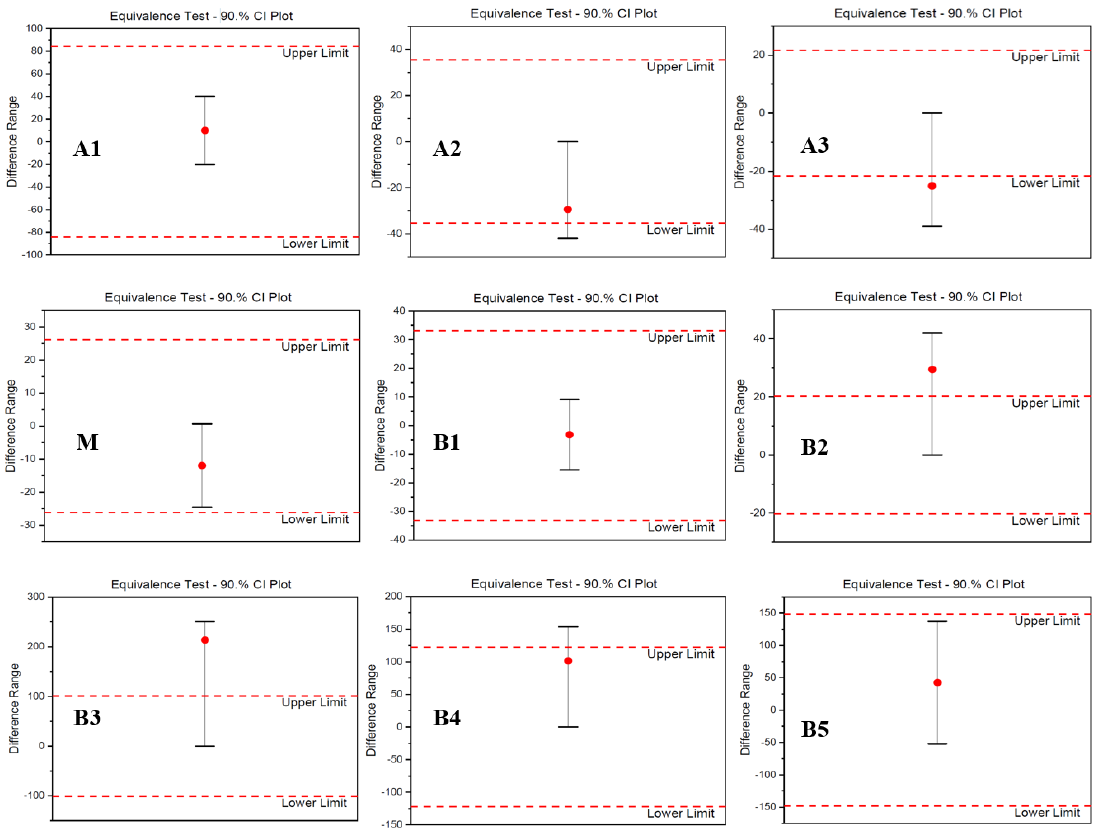
Figure 6. The VEGF-binding characteristics of the fractionated charge variants using the SPR using the Langmuir 1:1 binding model. The samples fractionated by the CEX method were obtained from the innovator (AVT) and the biosimilar candidate (SIMAB054) under the same operational conditions. A, M, and B, respectively, represent acidic, main, and basic fractions. The means of K D values were obtained from at least five measurements, and an equivalence test was used to compare each charge variant of SIMAB054 with those of AVT.